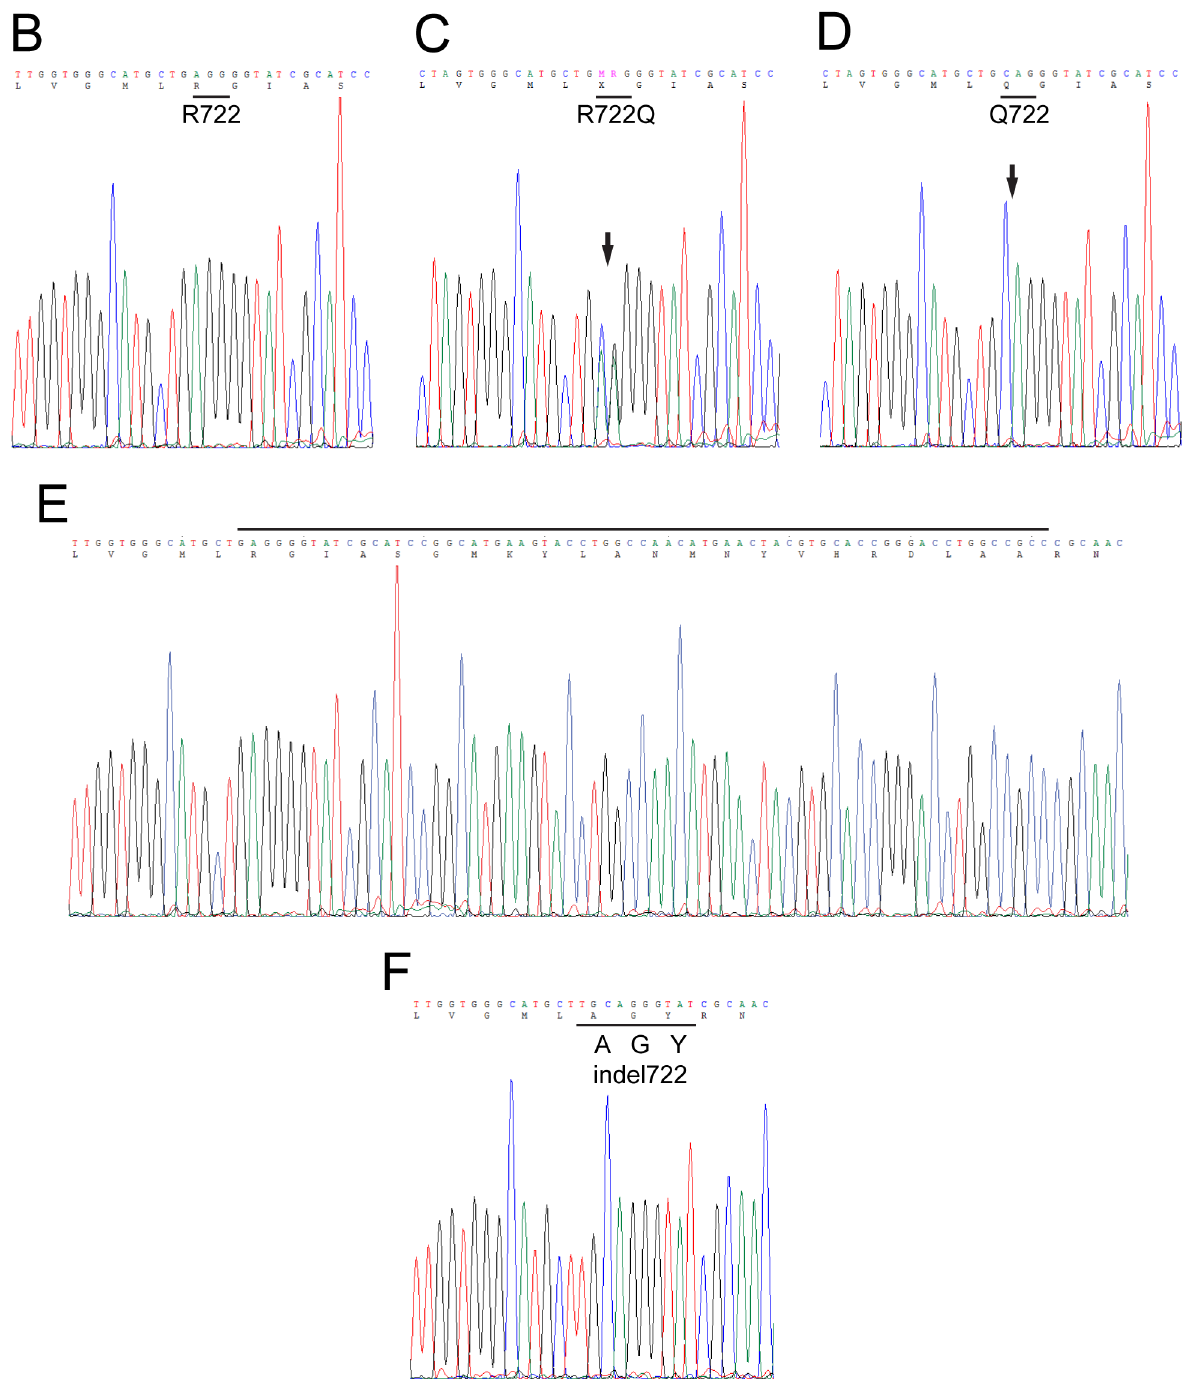
Figure 1. Generation of Epha2 -mutant versus Epha2 -null mice. ( A ) Schematic showing the exon organization and protein do- mains of Epha2 (RefSeq GRCm39, NM_010139.3) located on mouse chromosome 4 (physical location 141028532...141056695) spanning ~28 kb with 17 coding exons (boxes 1-17). The locations of the p.R722Q variant and the insertion-deletion mutation (exon-13) in the TK domain relative to the insertion site (exon-5) of the plasmid vector (pMCIneo) used to generate the null allele are indicated. Protein domains: SP, signal peptide, LBD, ligand-binding domain, FN3-1/2, fibronectin type-III 1 and 2, TM, transmembrane, TK—tyrosine kinase, SAM—sterile alpha-motif, IPI—PSD95/Dlg/ZO-1 (PDZ) binding motif. ( B – F ). Genomic DNA sequence of exon-13 showing the targeted p.R722Q missense variant in heterozygous Epha2 -Q722 mice ( C ) and homozygous Epha2 -Q722 mice ( D ) and the homozygous near-target insertion-deletion mutation in Epha2 -indel722 mice ( F ) compared with the corresponding wild-type regions ( B , E